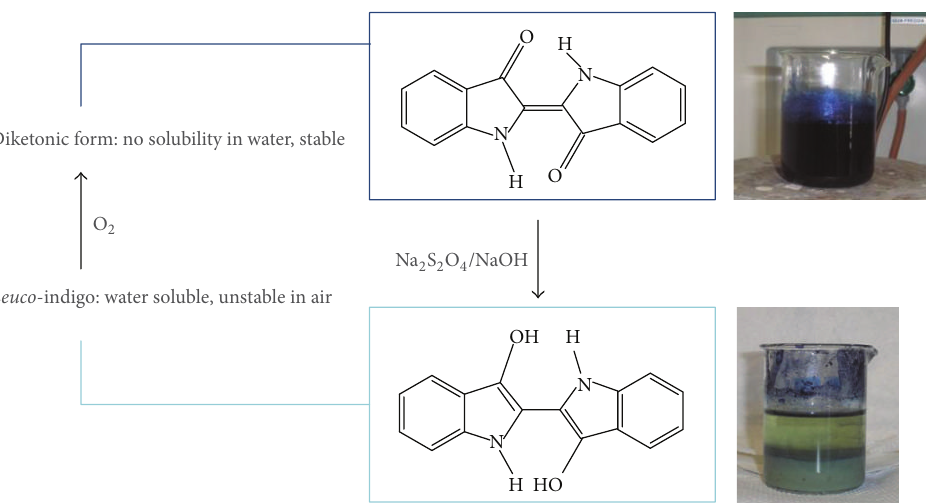
Figure 2: Chemical reactions involving indigo during the dyeing process. The indigo blue dye is the diketonic form.